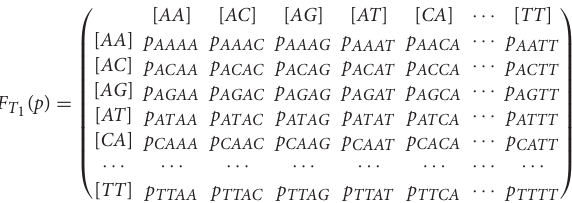
assigned to taxon a , i 2 is the state assigned to taxon b , etc.